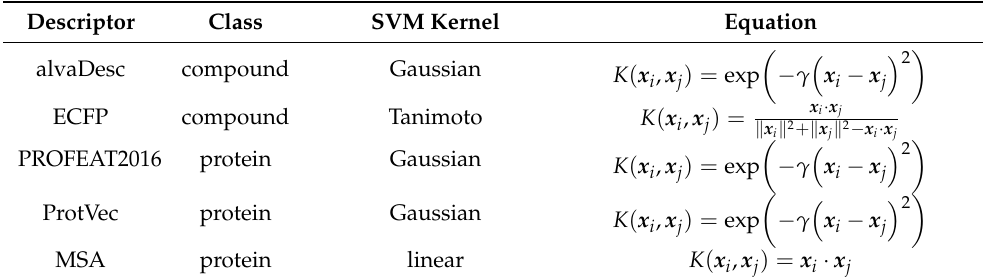
Table 2. Table of correspondence between compound or protein descriptors and SVM kernel functions.